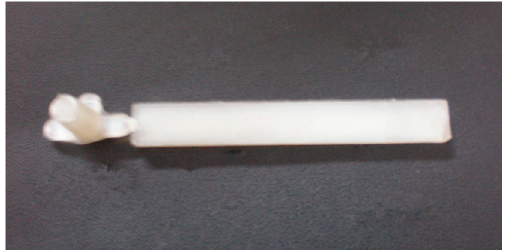
Figure 8. The molded part for droplet morphology experiment.